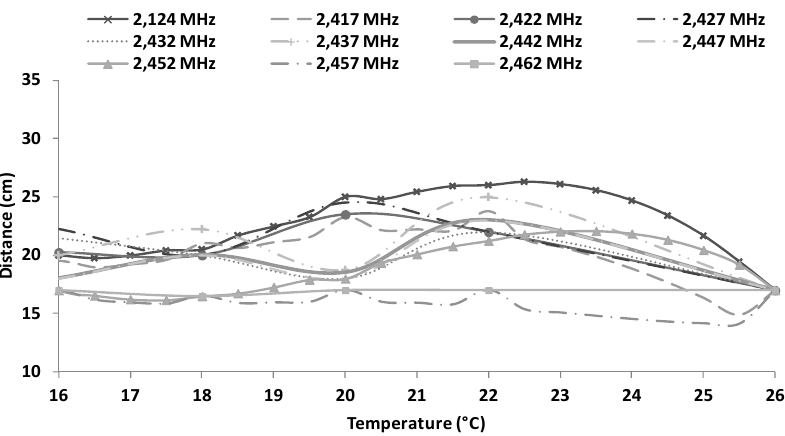
Figure 23. Estimated maximum distances for CCK transmission scheme.